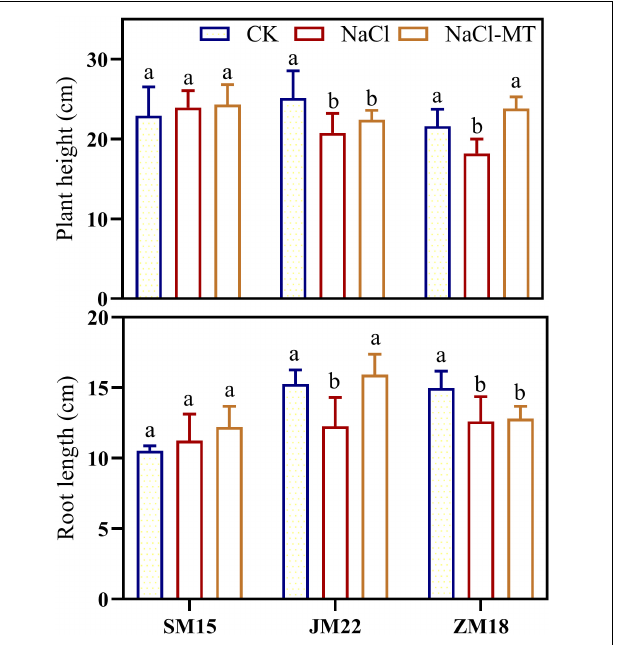
FIGURE 2 | Effects of MT on plant height and root length under salt stress. For each trait, bars with the same letter are not significantly different according to Duncan’s test at a p < 0.05